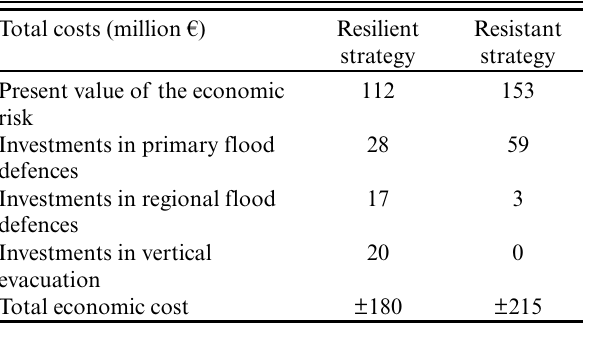
Table 2 . Total costs for the resilient and resistant